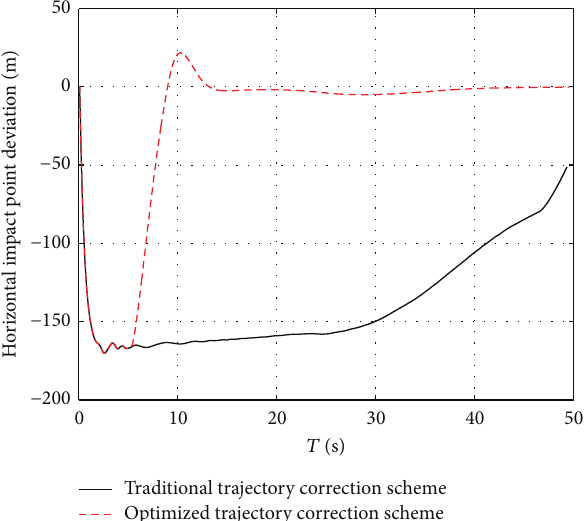
Figure 16: The change of horizontal impact point deviation.